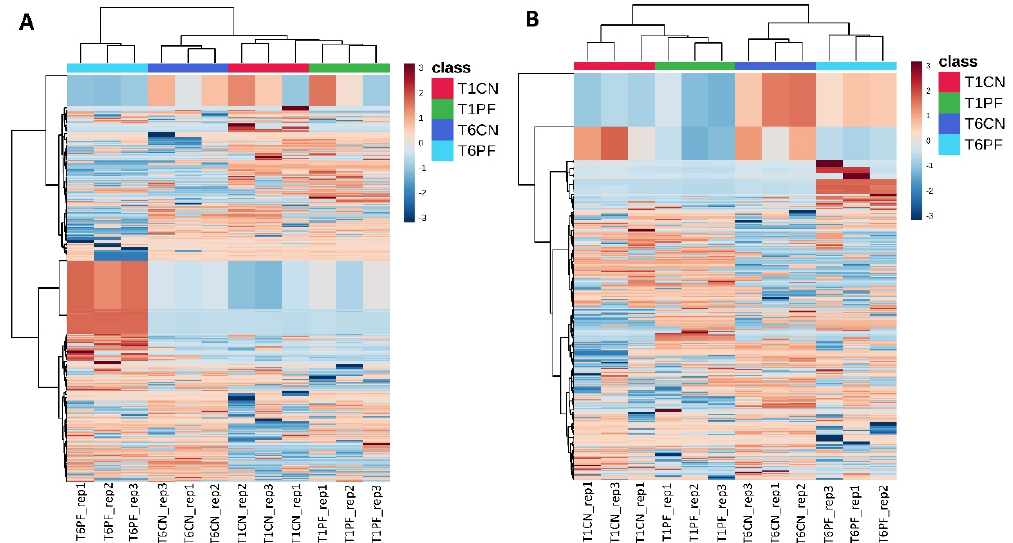
Figure 1. Heatmap-based unsupervised hierarchical cluster analysis (HCA—similarity index: Euclidean; dendrogram linkage method: Ward) of all compounds in the dataset of the non-heat-treated ( A ) and heat-treated ( B ) milk samples. Abbreviations: T1CN = non-inoculated sample incubated for 24 h; T1PF = inoculated sample incubated for 24 h; T6CN = non-inoculated sample incubated for 144 h; T6PF = inoculated sample incubated for 144 h.